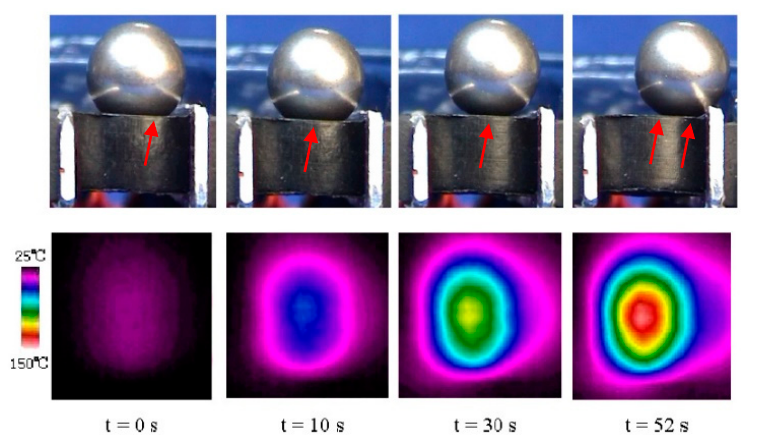
Figure 12. Image sequence, upon Joule heating, of the shape recovery and temperature distribution for S77%/MG15%/CB 8% [106]. Reproduced with permission from Cui, H.P; Smart for S77%/MG15%/CB 8% [106]. Reproduced with permission from Cui, H.P; Smart Materials and Materials and Structures; published by IOP Publishing, 2013. Structures; published by IOP Publishing,